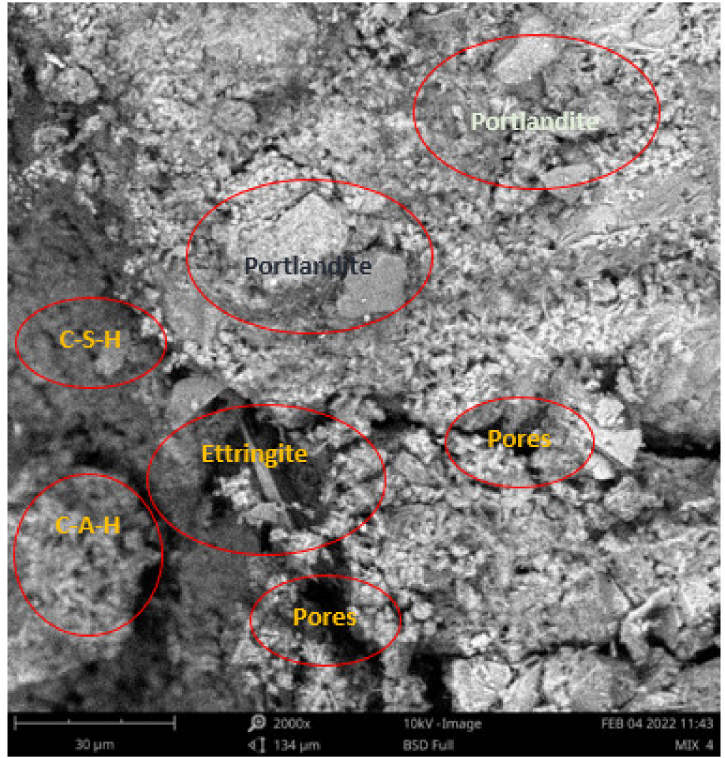
Figure 14. Micrograph of Y 4 concrete